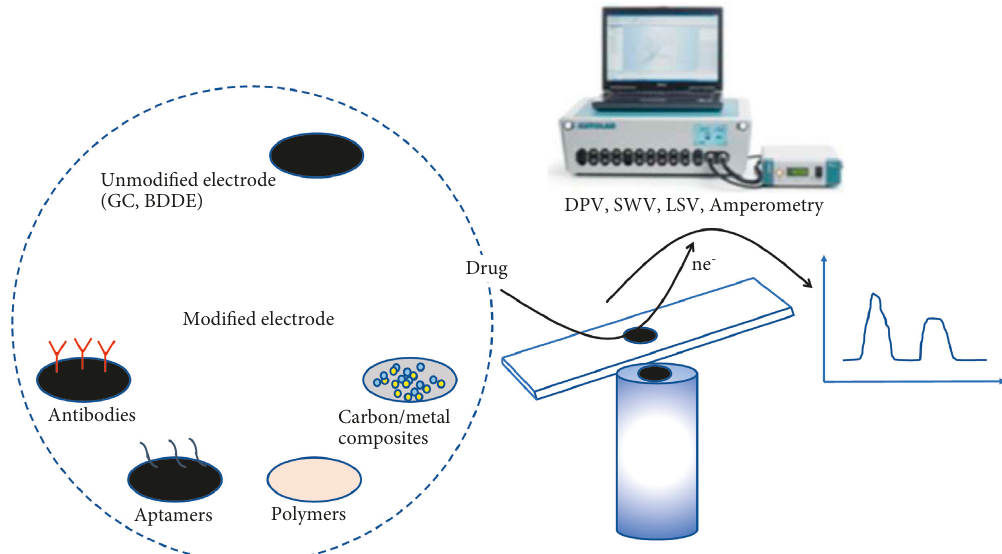
Figure 3: Several modification strategies and electrochemical techniques for drug analysis (the image is from